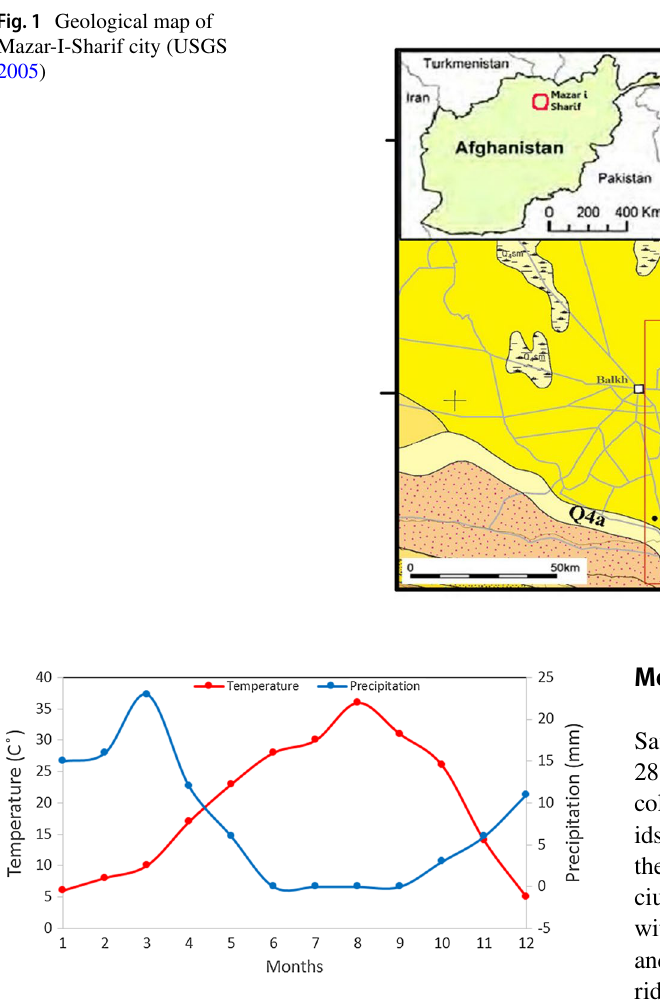
Fig. 2 Temperature and precipitation in